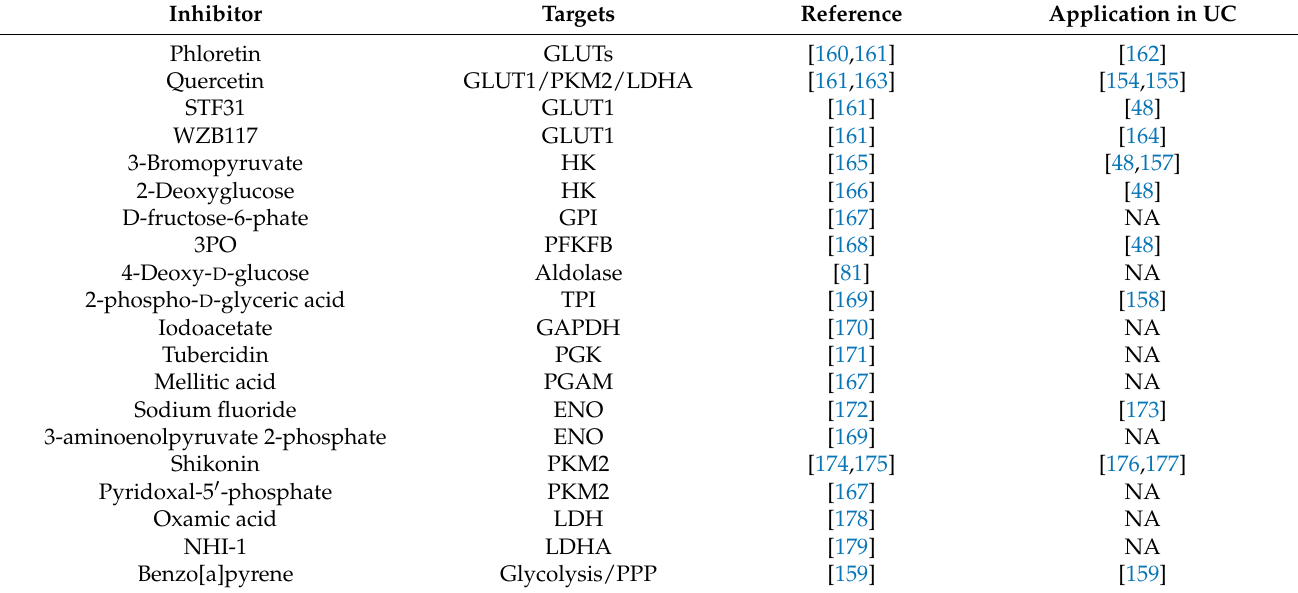
Table 3. Development phase of glycolytic enzyme compounds in UC and their pre-clinical or clinical effects. Inhibitor Targets Reference Application in UC Phloretin GLUTs